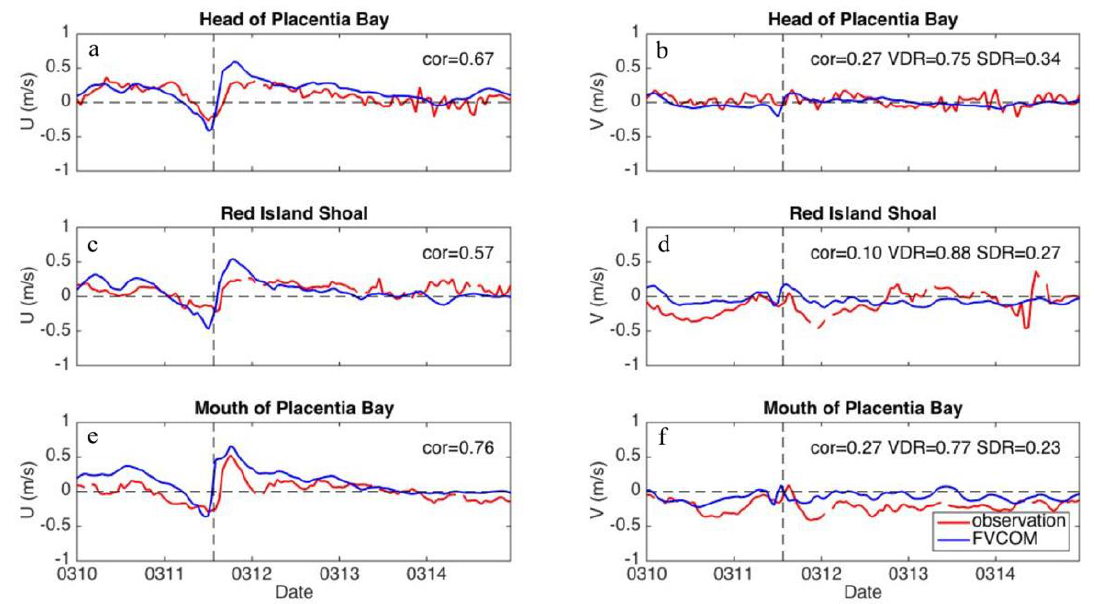
Figure 10. Time series of buoy-measured sea surface currents (red) compared to model results (blue) at HP ( a , b ), RI ( c , d ) and MP ( e , f ). The horizontal black dashed lines denote U = 0 m s − 1 and V = 0 m s − 1 . The vertical black dashed lines denote the time of landfall.